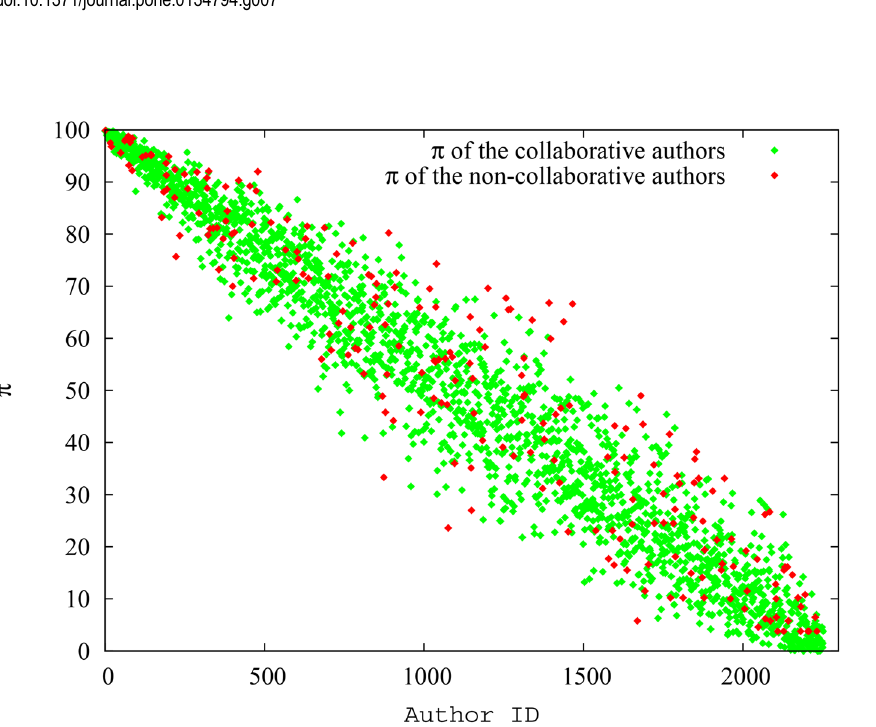
Fig 8. The spread of pagerank-index for collaborative and non-collaborative authors (as absolute values) in scenario 2. No group of authors have a clear advantage over the other group.